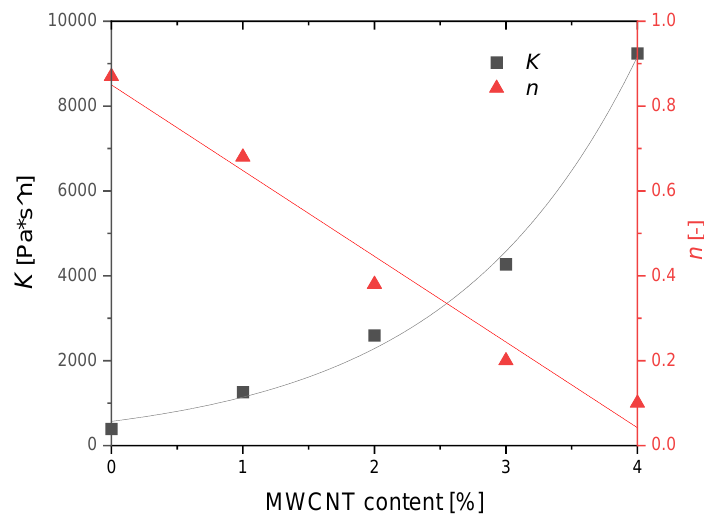
Figure 7. Flow consistency K and power-law n indexes as calculated by the fitting of the viscosity curves reported in Figure 6a.